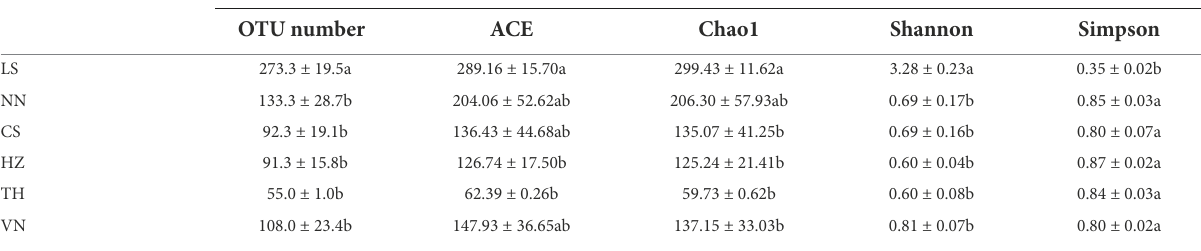
TABLE 3 Alpha diversity indices of gut bacterial communities in Cnaphalocrocis medinalis from different geographic sources. Geographic sources